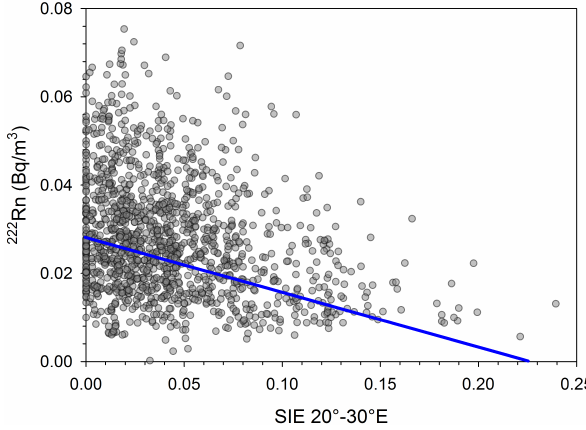
Fig. 11. Correlation between 222 Rn activity and SIE (unit: 10 6 km 2 ) between 20 ◦ E and 30 ◦ E for summer (JFM) based on respecting daily mean values. Regression (blue line) cal- culated by the Williamson–York method (Cantrell, 2008) with slope= − (0.124 ± 0.028) × 10 − 6 Bqm − 3 km − 2 , inter- cept=(0.028 ± 0.001)Bqm − 3